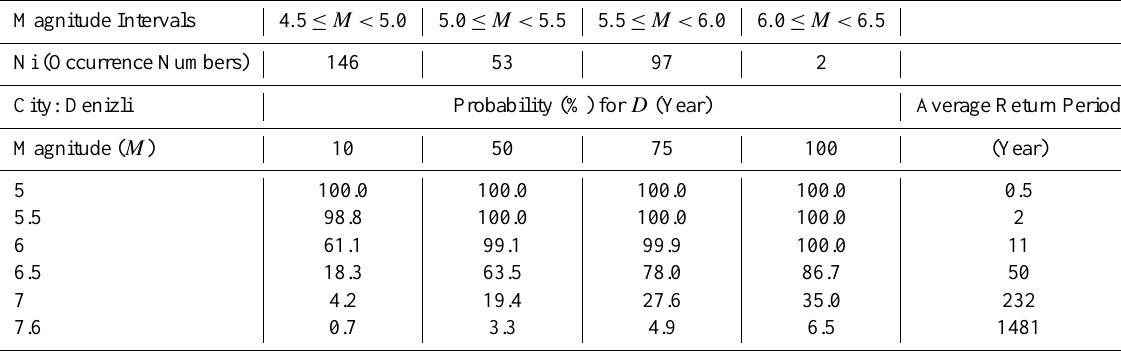
Table 3f. Earthquake occurrence probability (%) for D (Year) for Denizli city. Magnitude Intervals